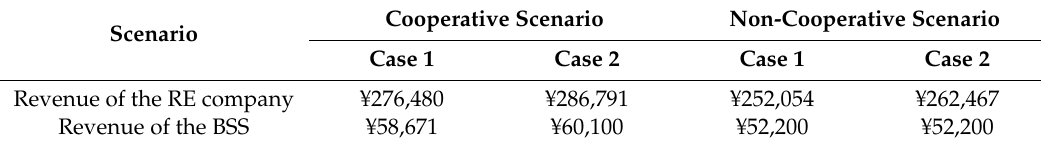
Table 7. The revenue of the RE company and the BSS in different scenario.